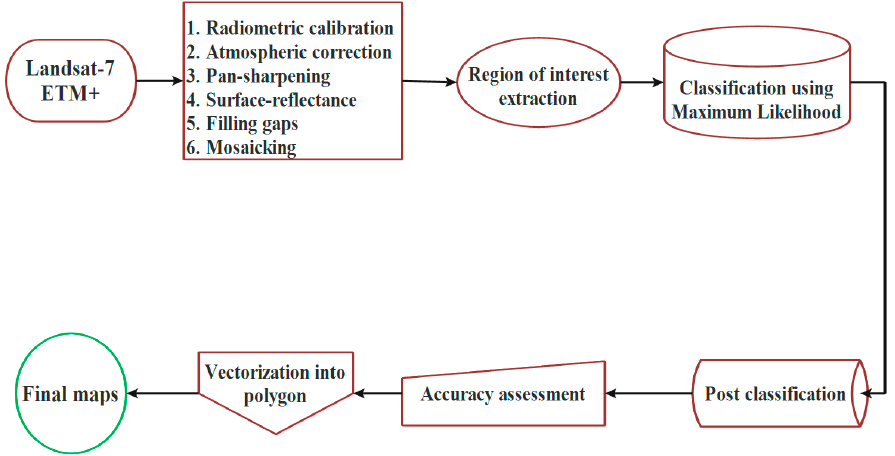
Figure 4. Flowchart of the research.